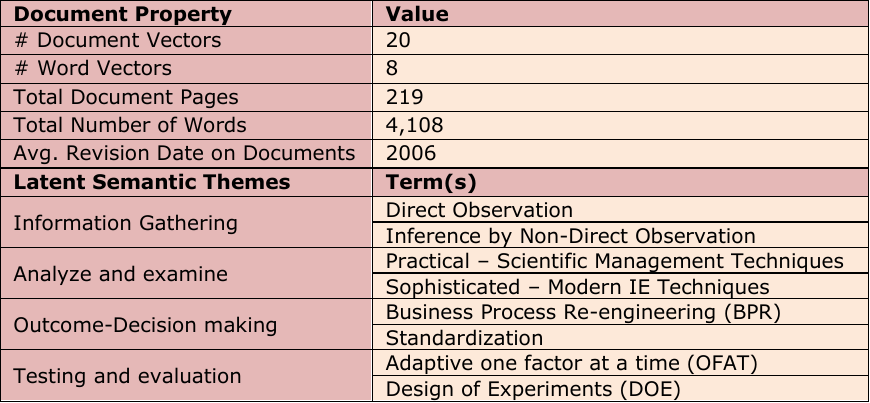
Figure 2. Representation of Document-Term(s) Matrix